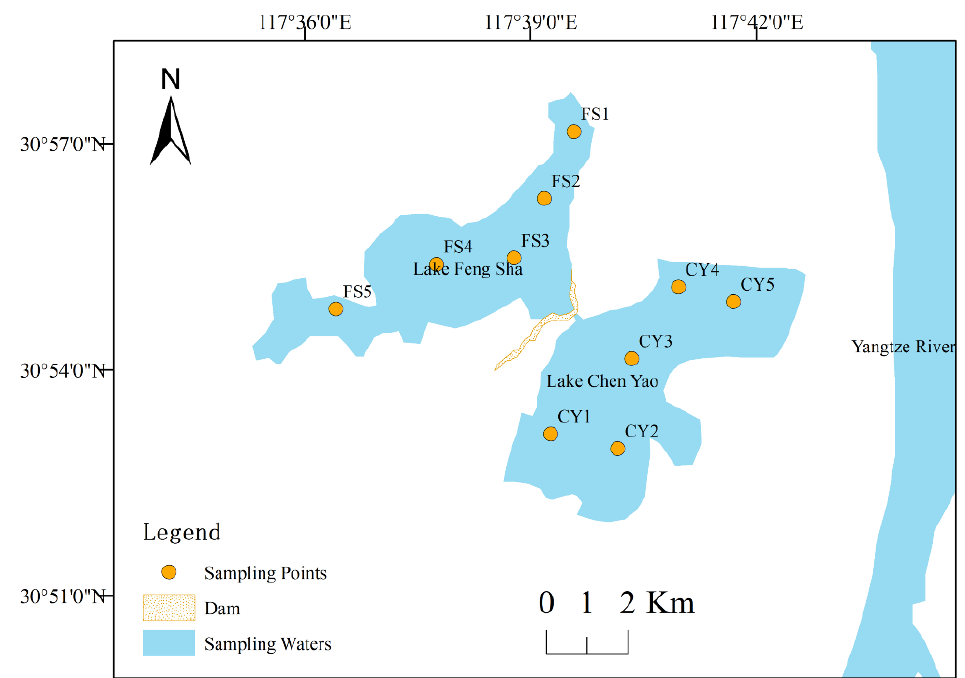
Figure 1. Distribution of sampling points in Lake Chen Yao and Lake Feng Sha study area.